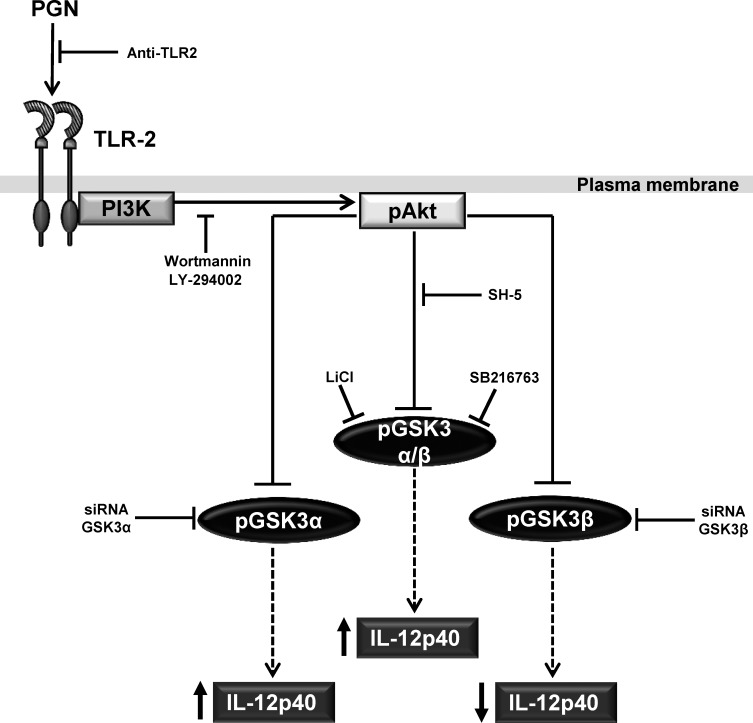
A working model of the signaling pathway involved on the IL-12p40 expression induced by PGN in BEC.PGN induces the activation of the TLR2/PI3K/Akt pathway, which in turn induces GSK3α and GSK3β phosphorylation/inhibition and this in turn up- or down-regulates IL-12p40 expression. Anti-TLR2, Wortmannin (PI3K inhibitor), LY-294002 (PI3K inhibitor) or SH-5 (Akt inhibitor) blocks the phosphorylation/inhibition of GSK3α and GSK3β. LiCl (GSK3 inhibitor), SB-216763 (GSK3 inhibitor) or siRNA GSK3α increases the expression of IL-12p40 while siRNA GSK3β decreases the expression of IL-12p40. Not represented in the diagram is the decrease in IL-12p40 expression when TLR2 is blocked with anti-TLR2 and when Akt is inhibited with Akt-i IV.